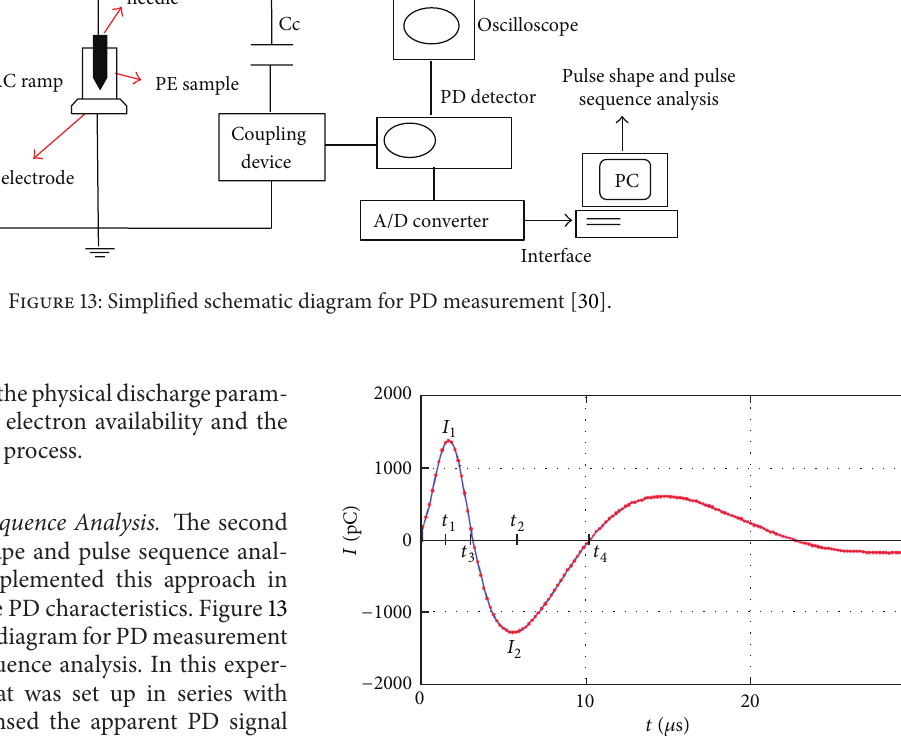
Figure 14: Typical PD and parameters for the pulse shape and pulse sequence analysis